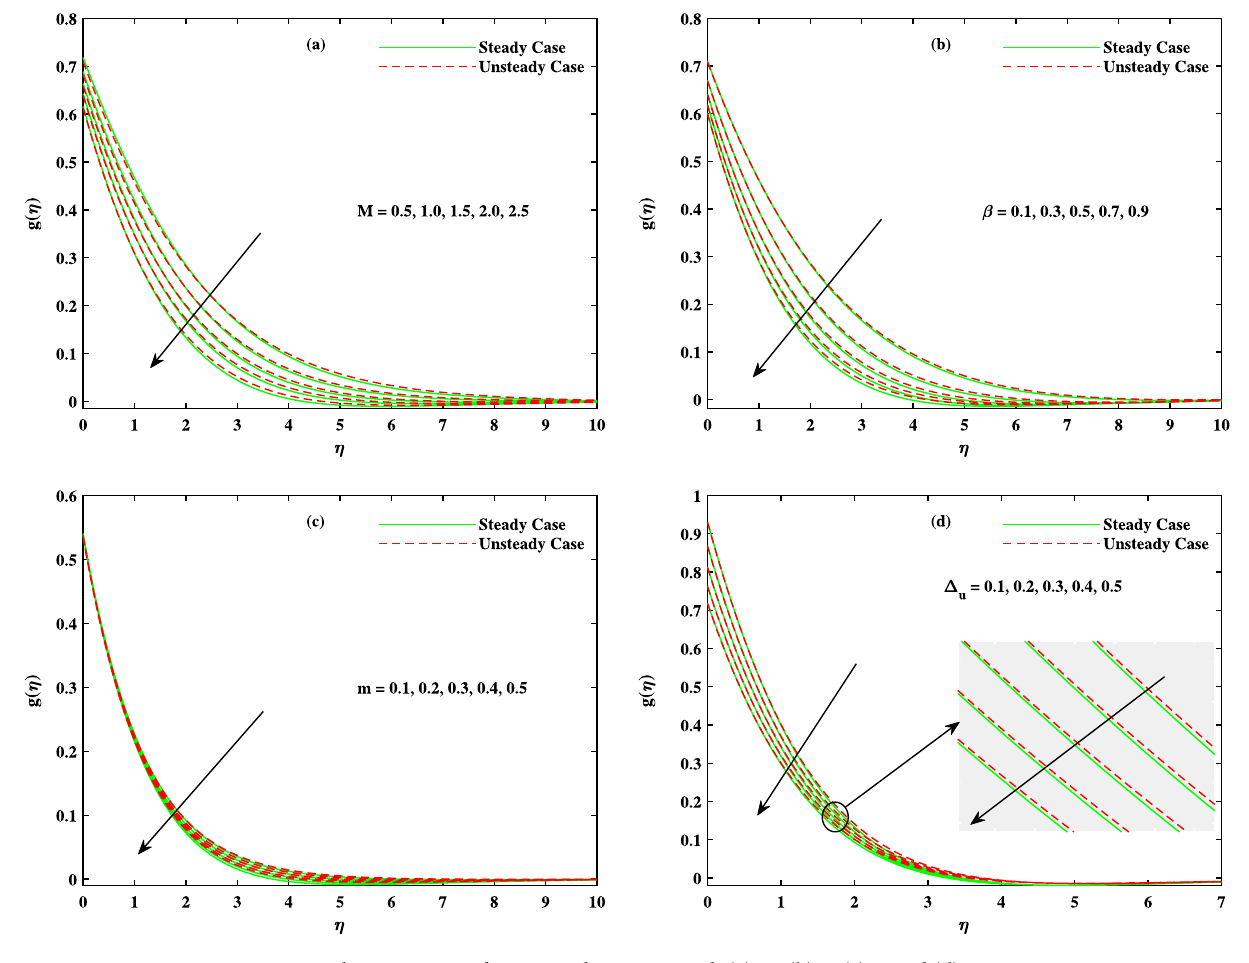
Figure 4. Fluctuation in y-direction velocity g (η) with ( a ) M , ( b ) β , ( c ) m and ( d ) (cid:31) u